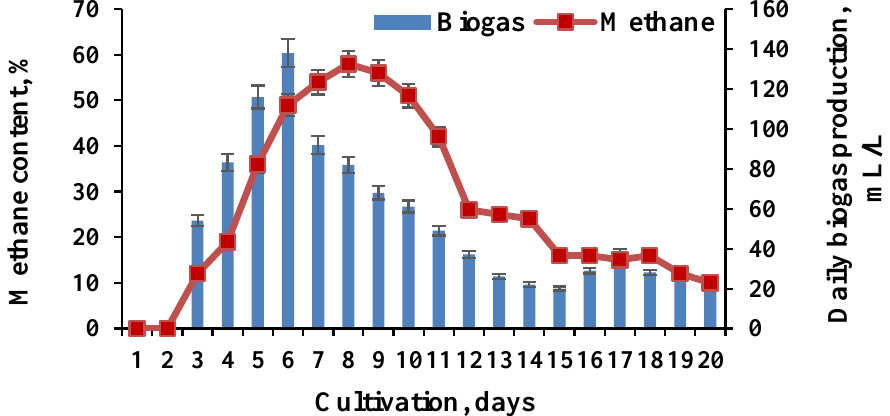
Figure 3. Biomethane production in a single methanogenic BR. Involving a two-stage AD system, where the processes were divided into a cascade of two separate bioreactors, the division of the processes into two consecutive bioreactors lead to higher energy yields for the two-stage system, realizing higher hydrogen and methane production compared to the traditional single-stage methanogenic process with different types of substrates as mentioned in the literature [27,28]. The calculations for the energy balance in the system lead to the conclusion that it is three-fold in favor of the two-stage process (Table